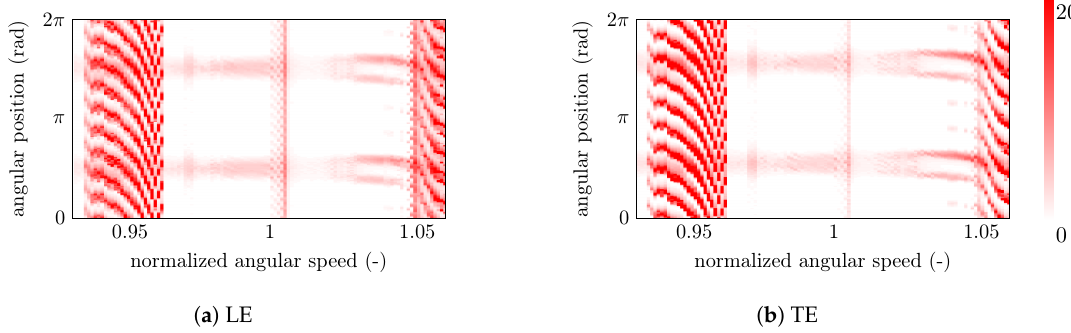
Figure 19. Evolution of the temperature profile with the angular speed for the HP compressor